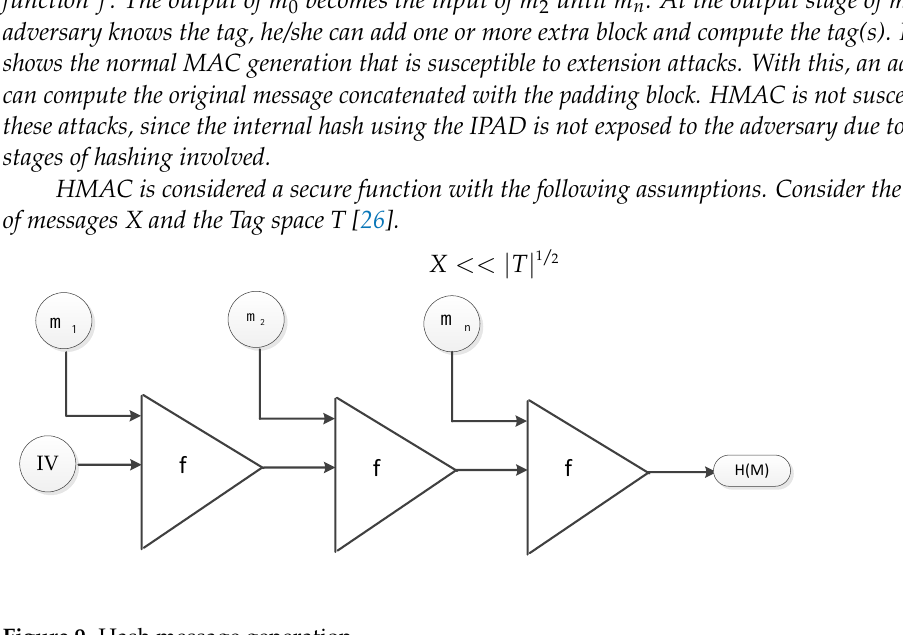
Figure 9. Hash message